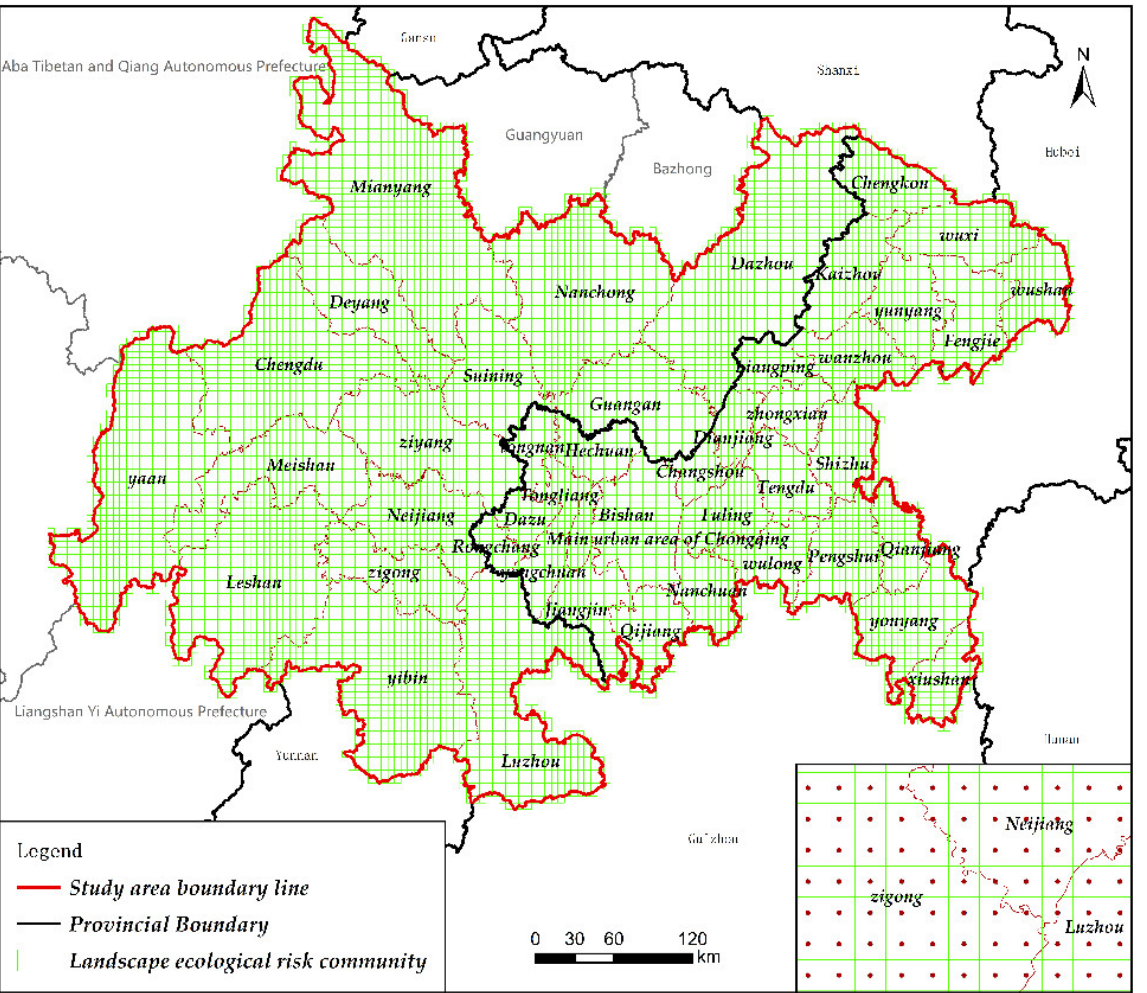
Figure 2. Schematic diagram of the ecological risk plot division in the study area.